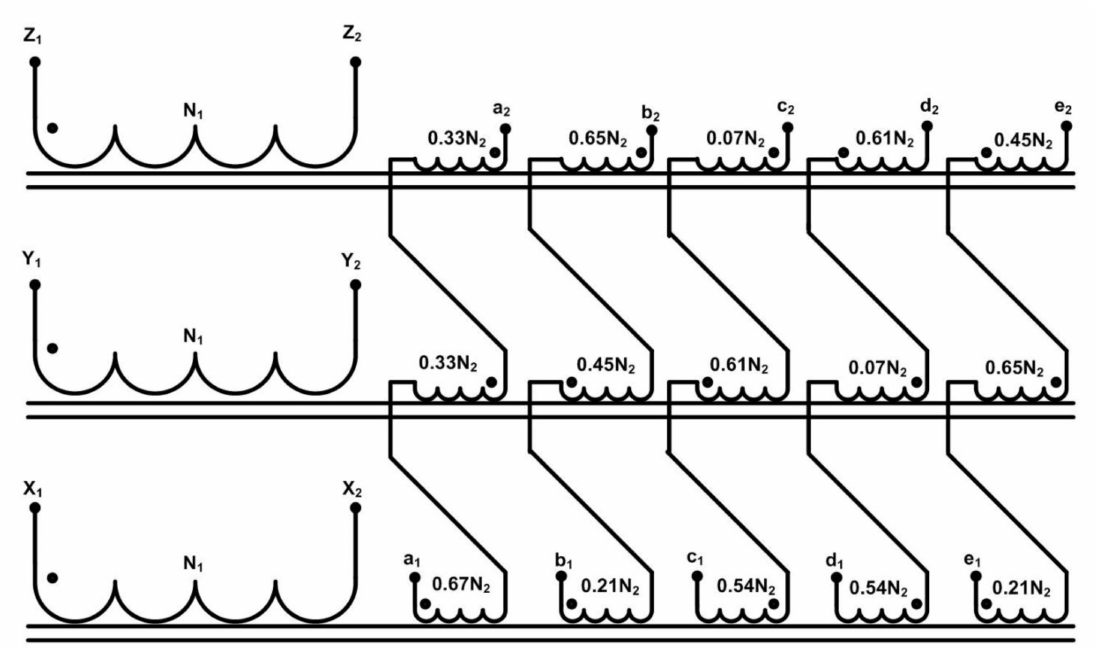
Figure 5. Configuration 1 for a three-phase to the five-phase transformer.